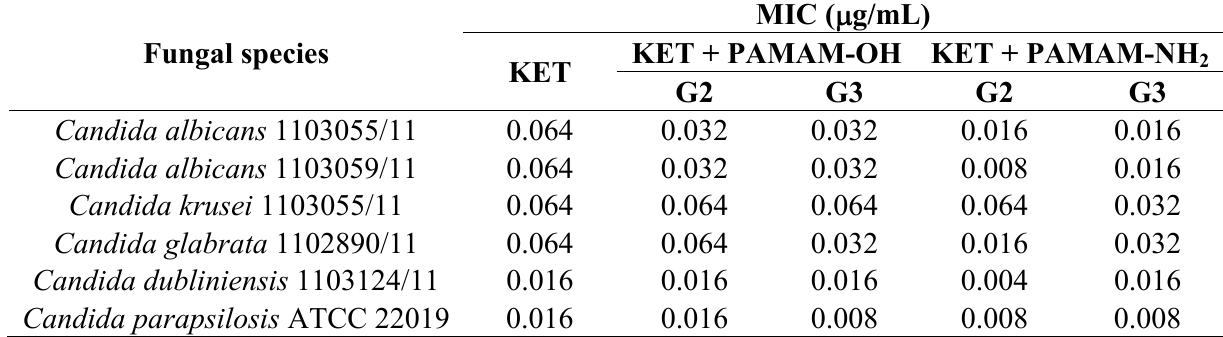
Table 1. Minimum Inhibitory Concentration—MIC (in μ g/mL) of ketoconazole in the presence of PAMAM-OH and PAMAM-NH dendrimers generation 2 (G2) and generation 3 (G3). 2